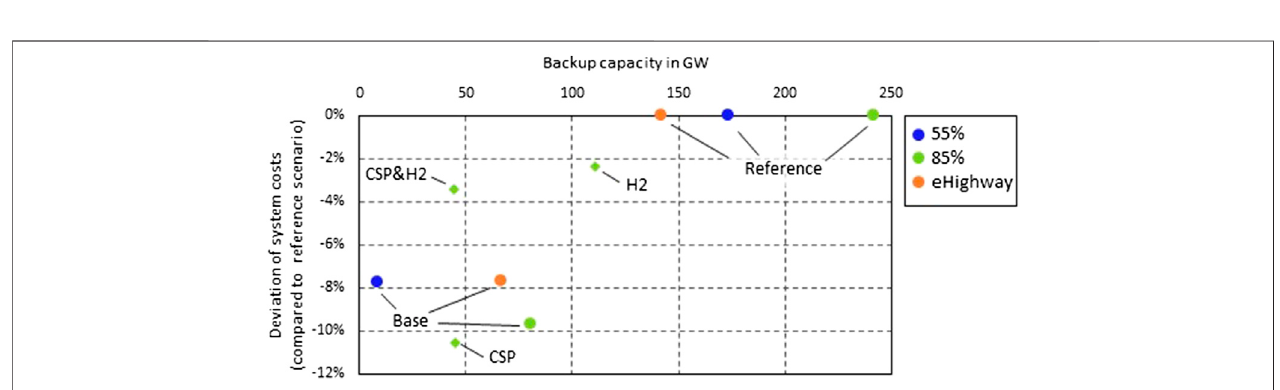
FIGURE4| Energycostsreduction(relativetoacorrespondingreferencecasewithoutexpansionof fl exibilityoptions)andsystemadequacyfordifferentEuropean energy